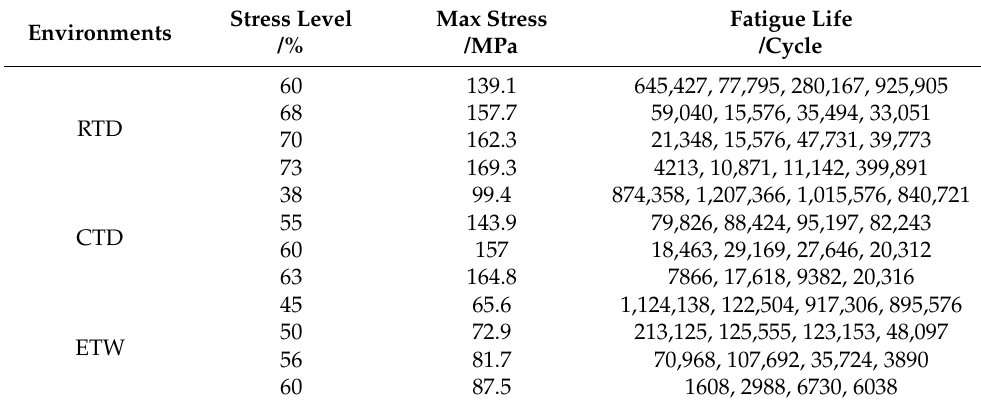
Table 6. Fatigue test results in three environments (stress ratio R =